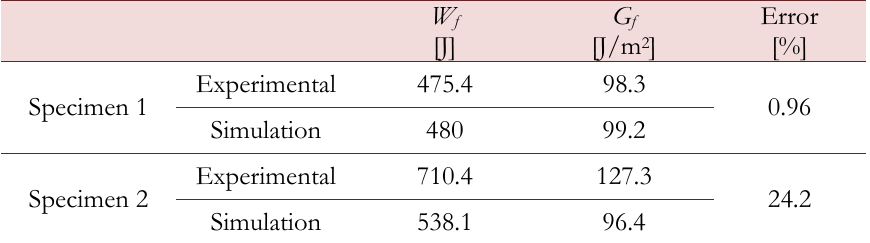
Table 3. Summary of the numerical and test